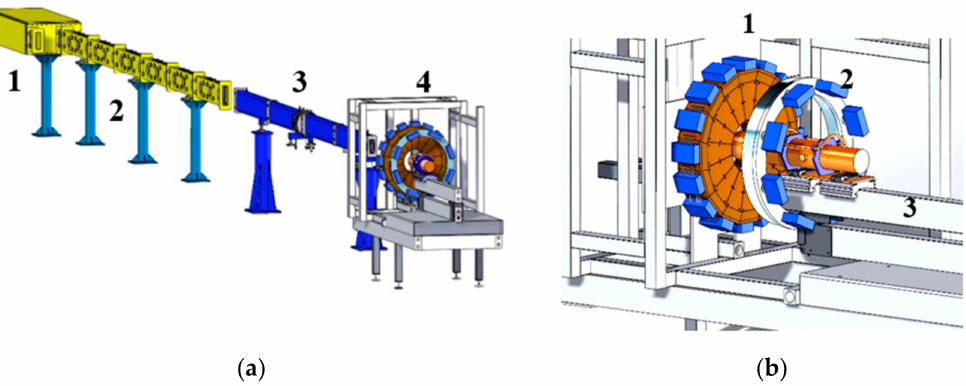
Figure 1. ( a ) The layout of the DN-6 diffractometer at the IBR-2 high-flux reactor. The neutron beam splitter (1), curved neutron guide (2), and parabolic neutron focusing system (3) are shown. The location of detector and sample environment systems (4) of the DN-6 diffractometer is marked. ( b ) Enlarged schematic layout of detector and sample environment systems of the DN-6 diffractometer. The 90-deg. scattering angle detector section (1), the low scattering angle detector section (2), the horizontal cryostat (3) and sample and high-pressure cell holders fixed on the movable slider are shown. The diffractometer components are mounted on a mechanical support